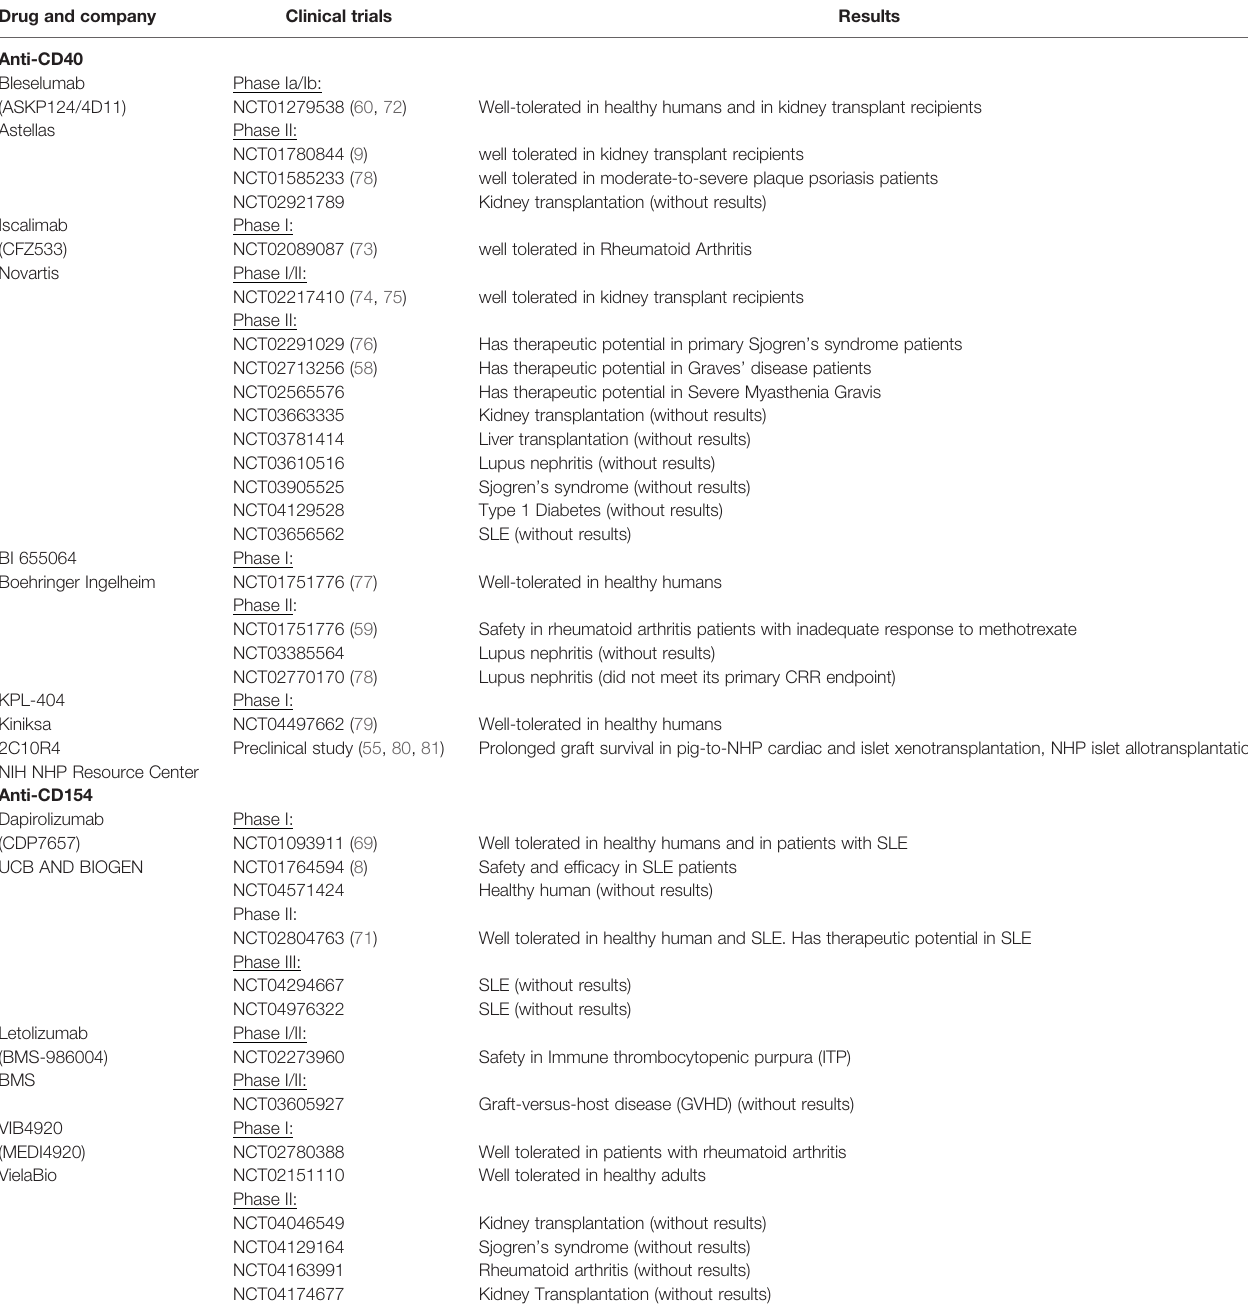
TABLE 6 | Agents that block the CD40/CD154 costimulation pathway that are currently in clinical trials and preclinical studies, an update of Bikhet 2021